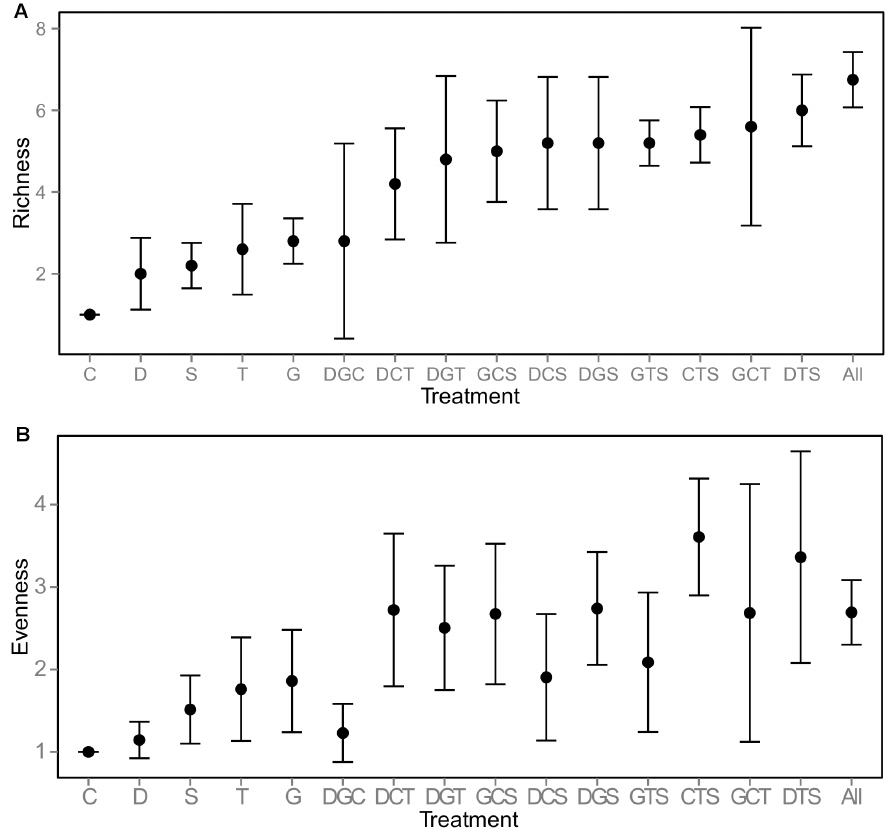
Figure 2. Canopy species richness (A) and evenness (B) in year four, by specific life-form combination (means ± 95% CI). Sample sizes: 1 life-form treatments: n=5 each; 3 life-form treatments: n=5 each; 5 life-form treatment: n=20.